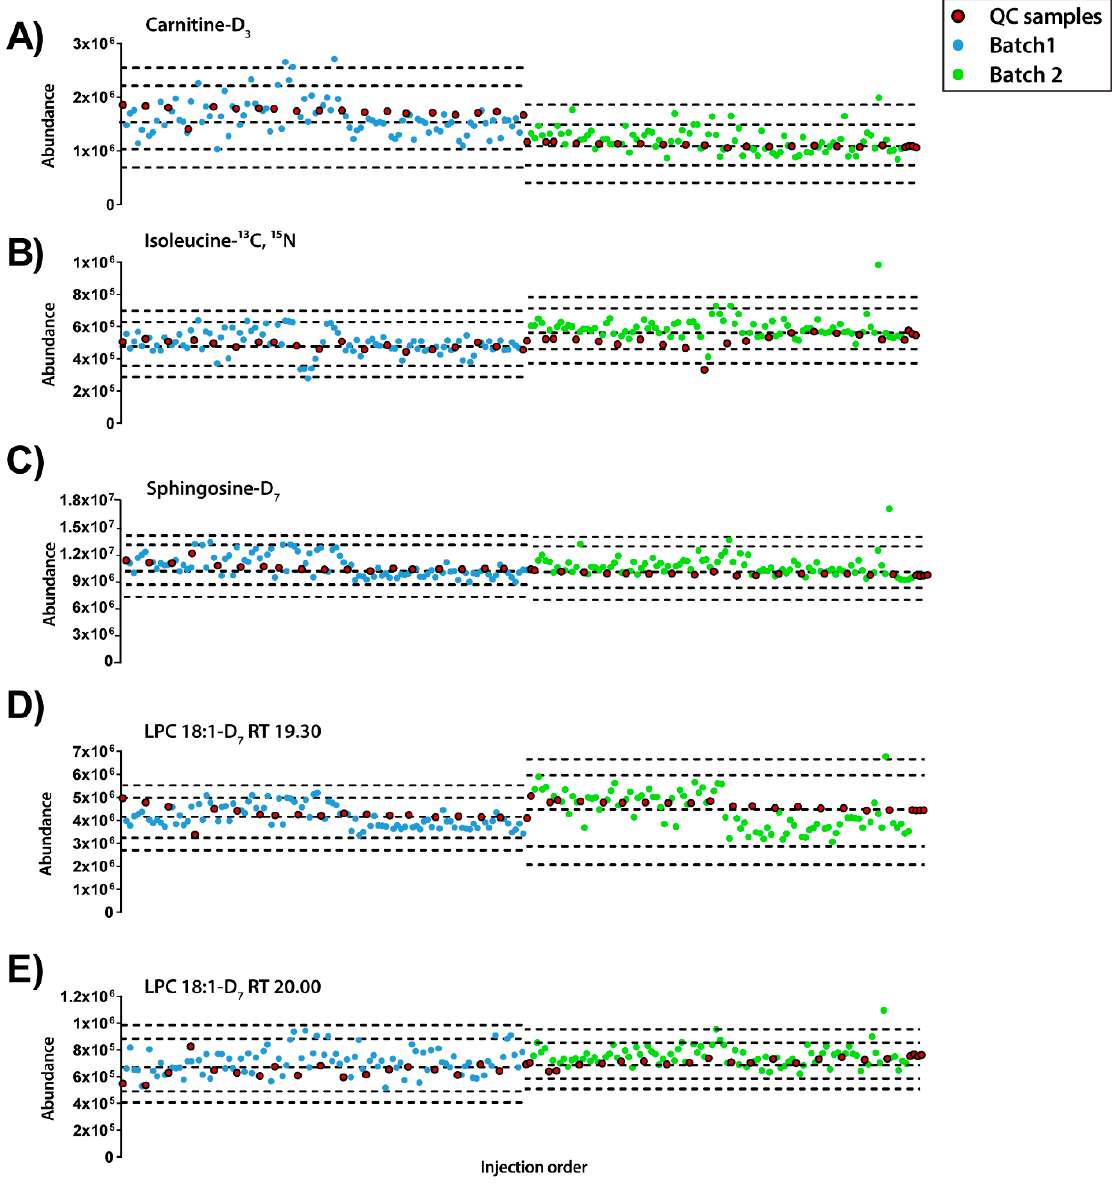
Figure 2. Quality control charts of the abundance of IS compounds in each sample according to the injection order for ESI+ mode. ( A ) Carnitine-D 3 RT 0.70min, RSD = 22.95%. ( B ) Isoleucine- 13 C, 15 N RT 0.77 min, RSD = 8.40%. ( C ) Sphingosine-D 7 RT 14.38 min, RSD = 5.15%. ( D ) LPC18:1-D 7 RT 19.30 min, RSD = 7.04%. ( E ) LPC18:1-D 7 RT 20.00 min, RSD = 8.82%. Legend . Y-axis : Abundance. X-axis : Sample order. Red circles : QCs; blue and green circles : Experimental samples measured in batch 1 and batch 2, respectively. Dotted lines represent the mean +/ − 2 and 3 SD for each batch independently.